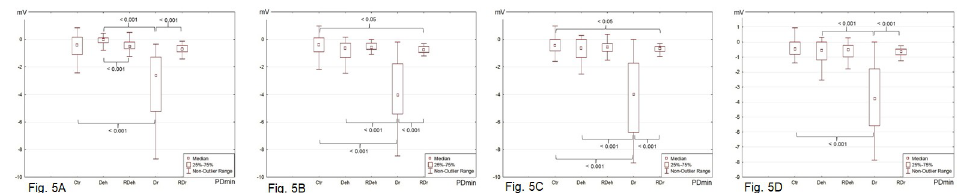
Fig 5. The minimal transepithelial electric potential (PDmin, mV) measured in 15s mechanical–chemical stimulation of the isolated rabbit skin specimens with the use of: ( a ) Ringer’s solution (RH); ( b ) bumetanide (0.1 mM) solution; ( c ) amiloride (0.1 mM) solution; ( d ) solution of amiloride (0.1 mM) and bumetanide (0.1 mM). The skin specimens were pre–treated as follows: Ctr (control: skin specimens incubated in RH for 30 min), Deh (dehydrated: skin specimens incubated in 10% NaCl for 30 min), RDeh (rehydrated after dehydration: skin specimens rehydrated in RH for 30 min after incubation in 10% NaCl for 30 min), Dr (dried: skin specimens dried at 37˚C for 60 min), RDr (rehydrated after drying: skin specimens rehydrated in RH for 60 min after drying at 37˚C for 60 min). The p values < 0.05 were considered as statistically significant.